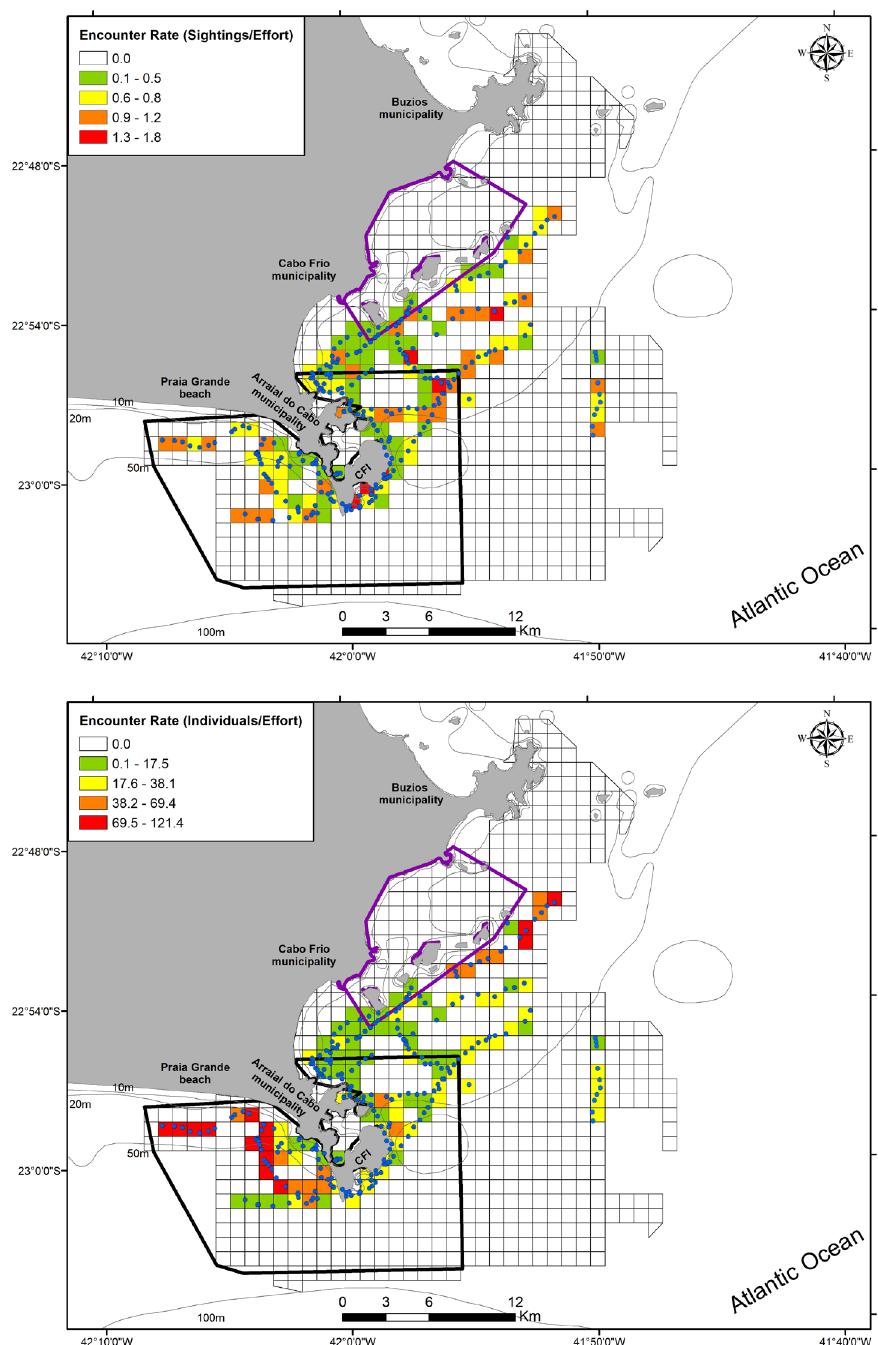
Figure 3. Encounter rates of bottlenose dolphins Tursiops truncatus truncatus in Cabo Frio coast, Rio de Janeiro, Brazil within 1x1 km 2 grid cells. Gray points indicate sightings of dolphins. Isobaths are shown as continuous black lines. Continuous blue line indicates Conservation Unit Reserva Extrativista Marinha do Arraial do Cabo and purple line Conservation Unit Area de Proteção Ambiental do Pau-Brasil. CFI = Cabo Frio island. Upper figure: Encounter rate calculated as number of sighted dolphin groups in a given grid/survey effort, calculated as the linear boat trajectories, in kilometers. Bottom figure: Encounter rate calculated as number of individuals in a given grid/ survey effort, calculated as the linear boat trajectories, in